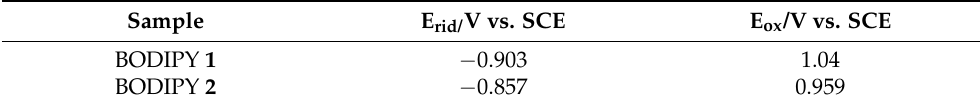
Table 2. Redox data of BODIPY 1 and 2 . Sample